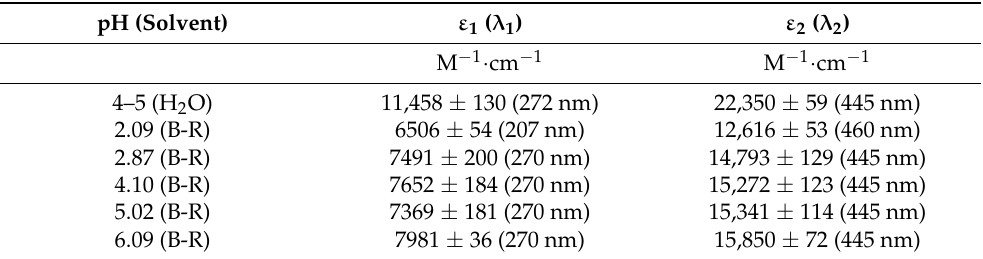
Table 1. The values of wavelength and molar coefficient ( ε ) at different pH of the tropaeolin OO solution, T = 20 ◦